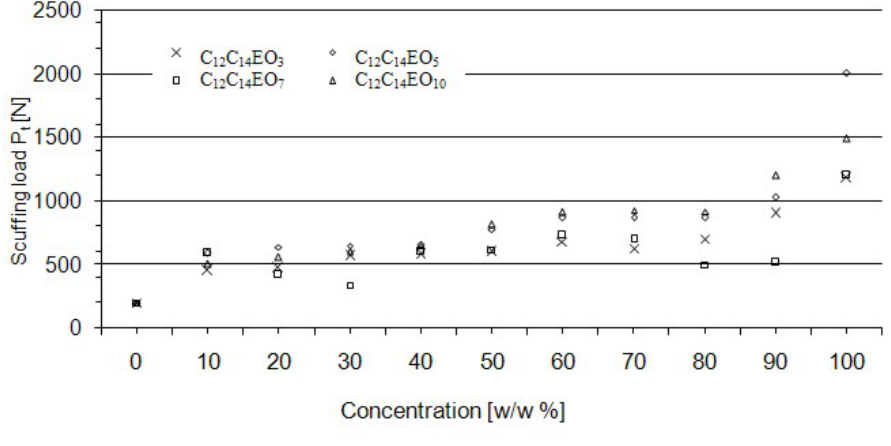
Figure 7. The dependence of scuffing load on concentration of aqueous solutions of alcohols ethoxylated with 3–C moles of ethylene oxide. Four-ball tester, rotational speed of spindle 200 rpm, load increasing rate 409